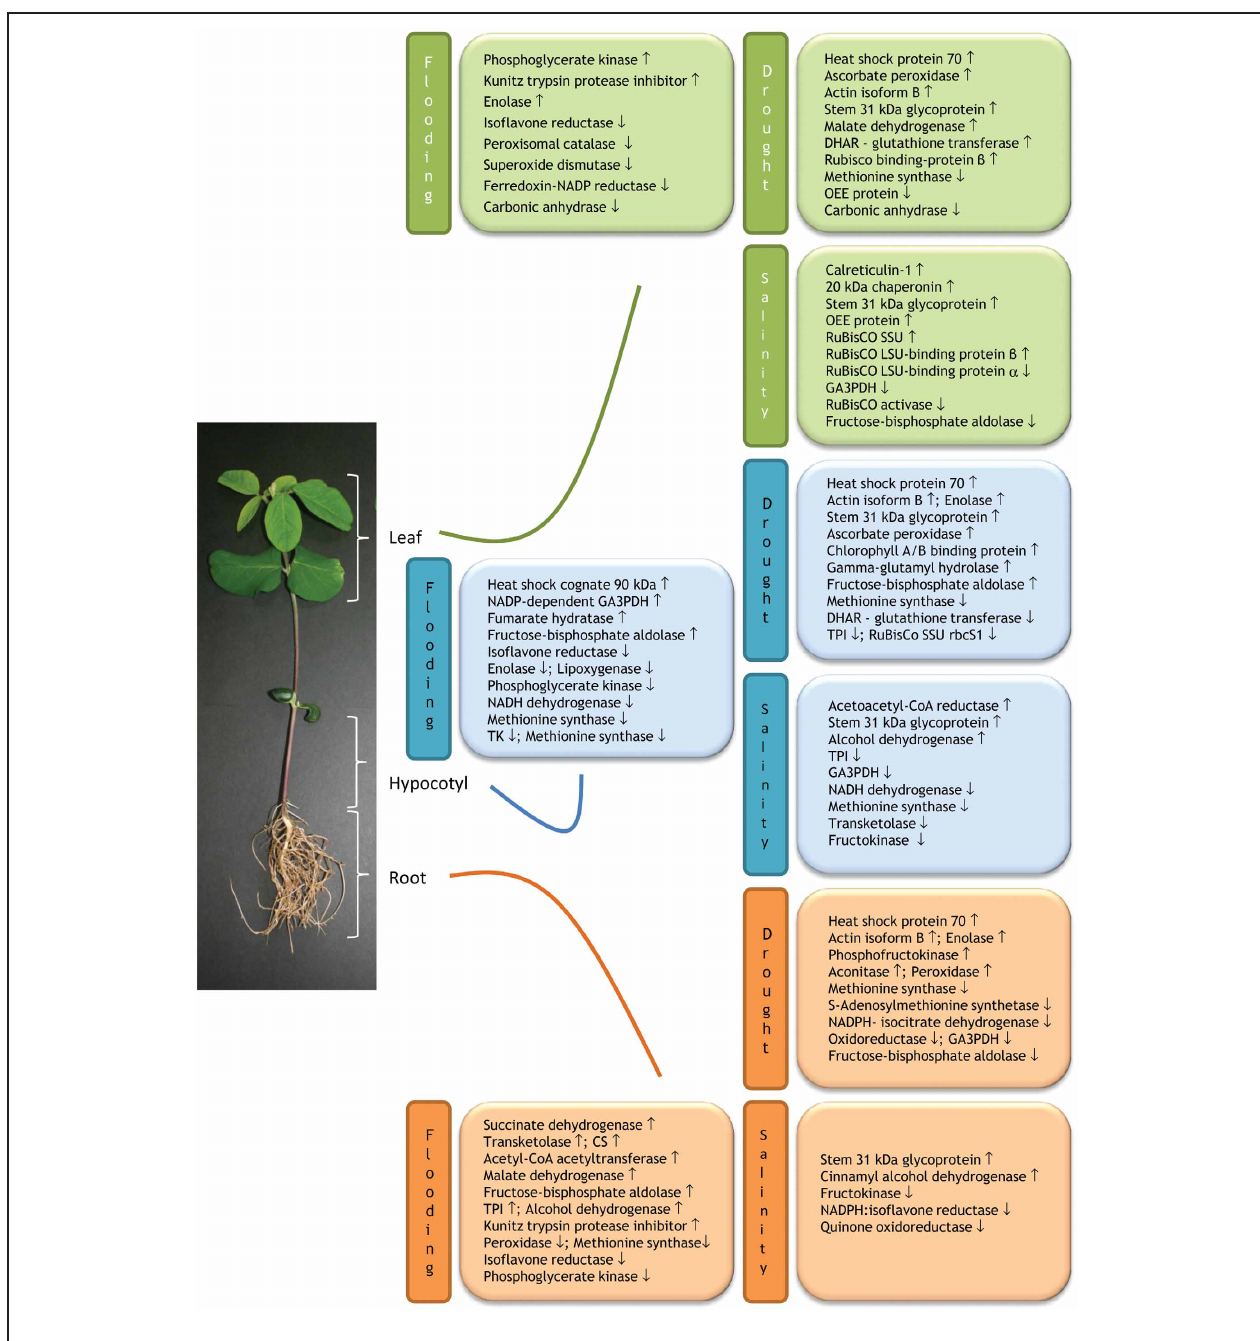
FIGURE 1 | Schematic illustration of organ-specific expression of proteins in response to drought, flooding, and salinity stresses. The scheme is based on the published organ-specific proteomic works on soybean ( Glycine max L.) under the mentioned abiotic stresses. Up and down arrows indicate stress-induced increase and